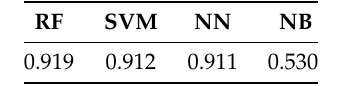
Table 3. F-measures for label visibility classification.